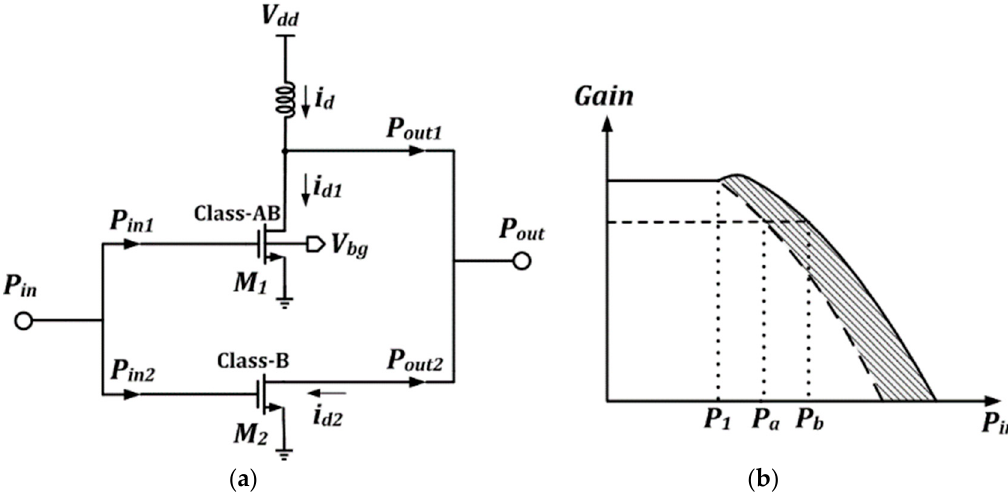
Figure 1. ( a ) Operation principle and ( b ) Input/output characteristics of the dual-switching transistor (DST).